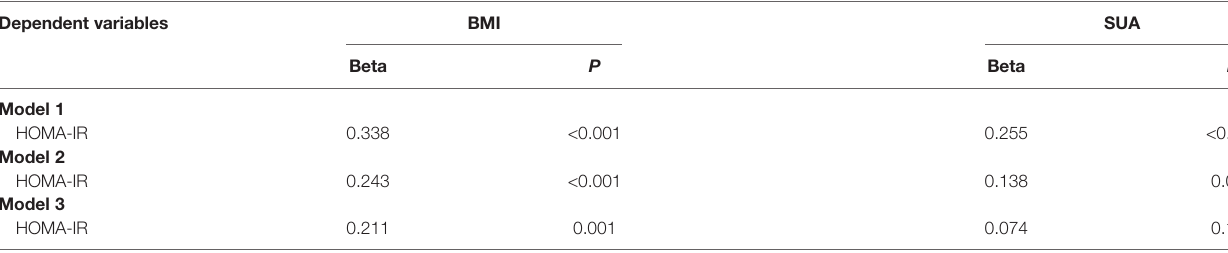
TABLE 3 | Multiple linear regression examining the association of BMI and SUA with HOMA-IR.